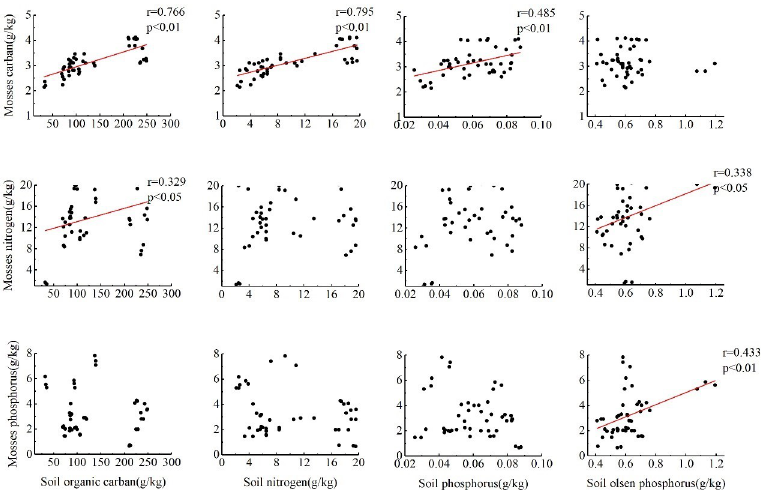
Fig 3. Correlation analysis between mosses and soil C, N, and P contents in karst rocky desertification areas.